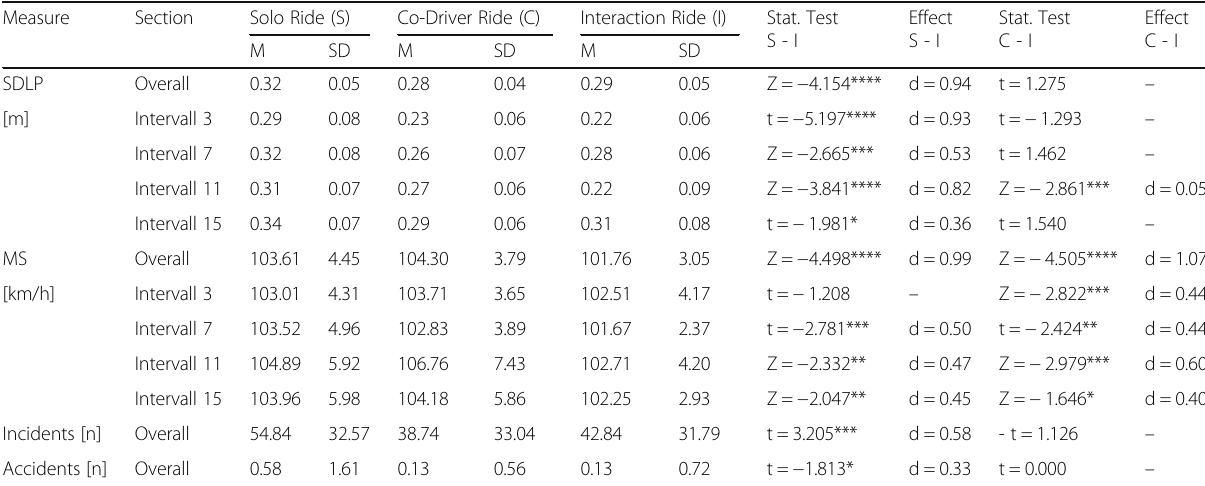
Table 5 Results related to driving performance Measure